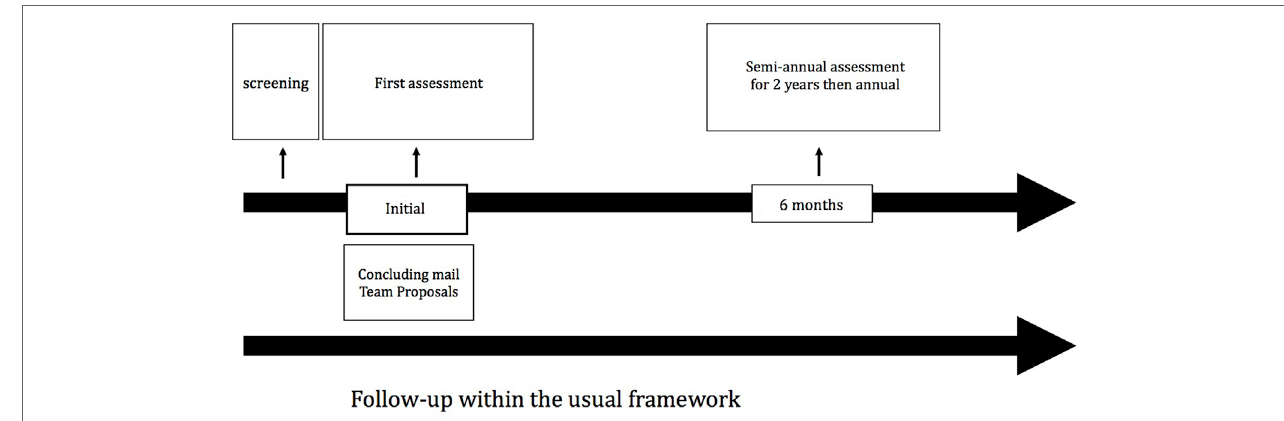
FigurE 2 | Follow-up of an individual patient within the French Treatment-Resistant Depression